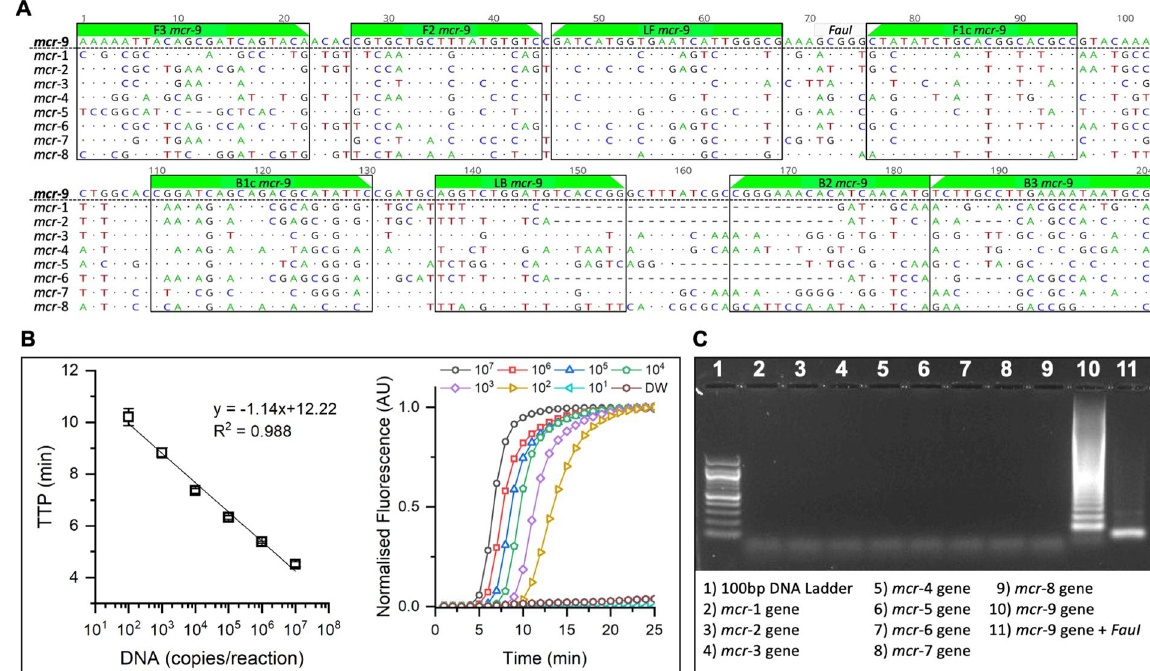
Figure 2. Sequence alignment, primers location and mcr − 9 LAMP assay performance. ( A ) Sequence alignment for mcr − 1 to mcr − 9 showing priming region and the location of the FauI restriction site. Compared to the reference sequence, mcr − 9, mismatches in the alignment are displayed as AGTC. Matched nucleotides are represented as dots and gaps are represented as dashes. ( B ) Standard curve and real-time amplification profiles obtained with the mcr − 9 LAMP assay and synthetic DNA at concentrations ranging from 10 2 to 10 7 copies per reaction (including non-template control). Experiments were carried-out in a real-time qPCR platform in triplicates. ( C ) Gel electrophoresis confirming specificity of mcr − 9 LAMP assay. Line 1 shows a 100 bp DNA ladder. Lines 2 to 10 show the amplification product obtained from synthetic DNA carrying mcr − 1 to mcr − 9 sequences against the mcr − 9 LAMP assay. Line 11 shows the specific mcr − 9 LAMP product after digestion with FauI